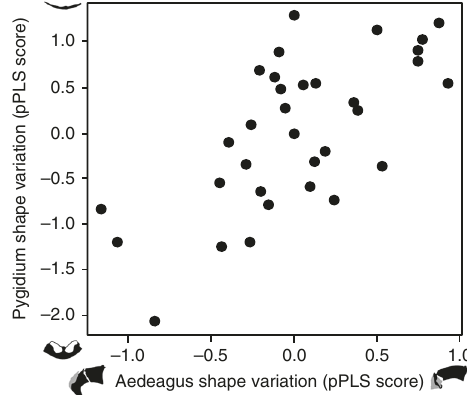
Fig. 4 Correlated evolution of female and male genitalia. Plot from phylogenetic two-block partial least squares (pPLS) analyses of female (pygidium) and male (aedeagus) genital shape. Shape variation is illustrated using outlines from species with representative scores along the fi rst latent variable obtained from a phylogenetically controlled partial least- squares analysis of size-normalized Fourier coef fi cients. These axes correspond closely to the major axes of variation from principal components analyses of shape data prior to controlling for phylogeny (Fig. 2, Supplementary Figs. 2 and